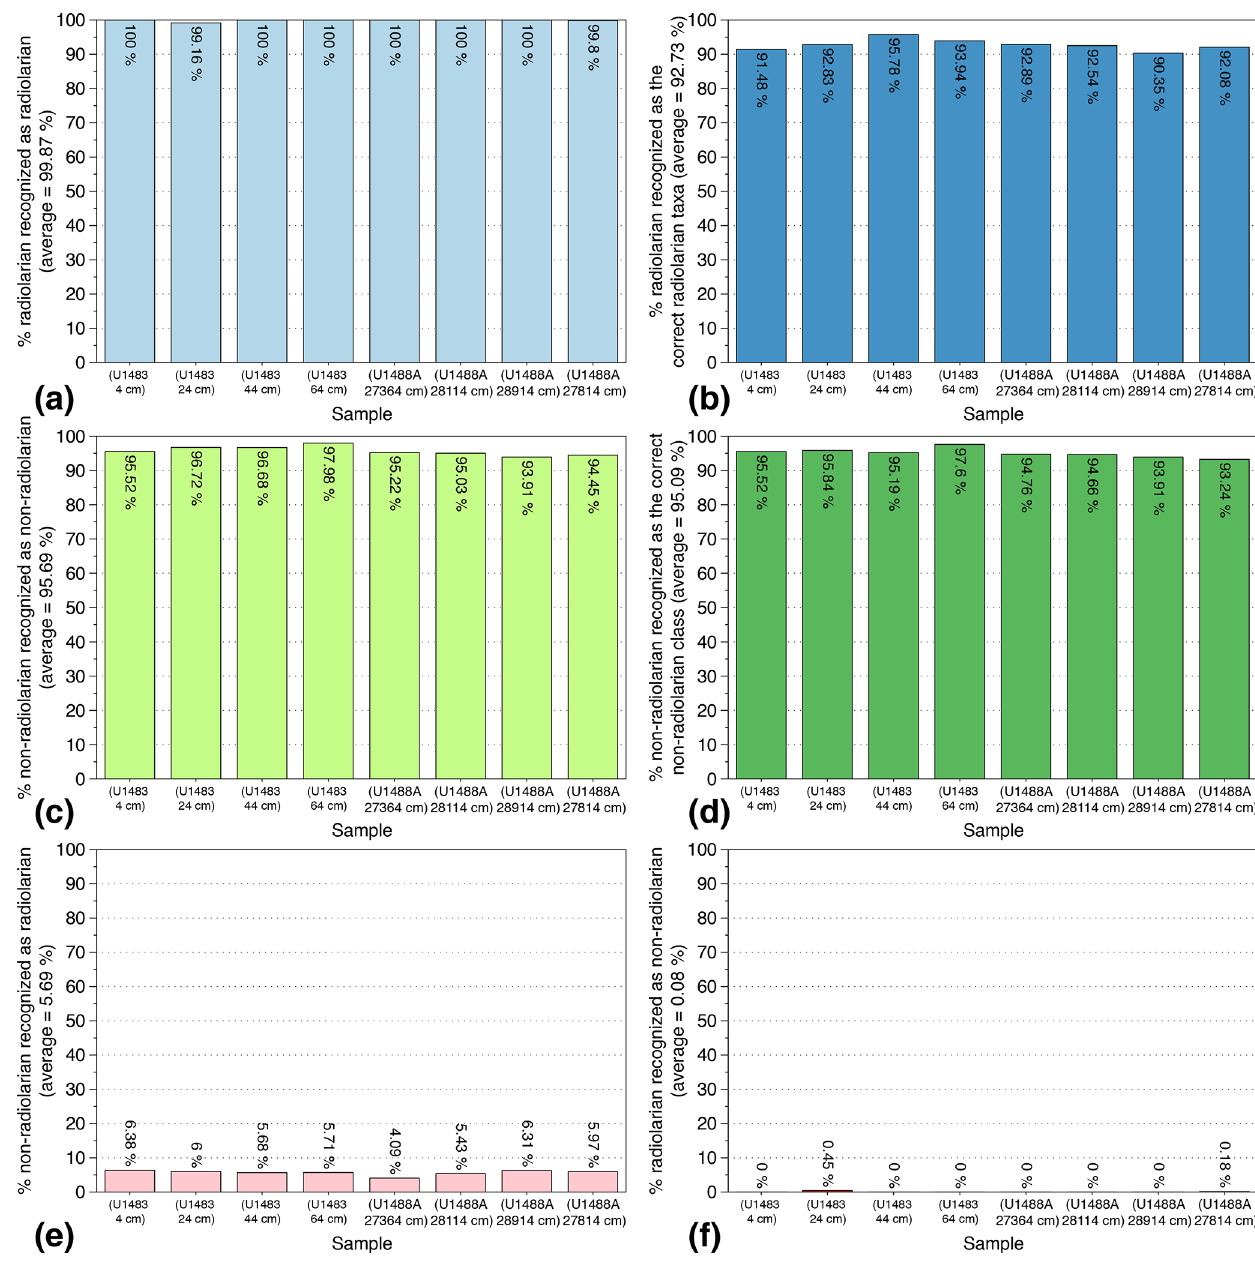
Figure 5. Identification indices evaluated on eight Quaternary and Miocene random samples recovered from cores U1483 and U1488A (IODP Expedition